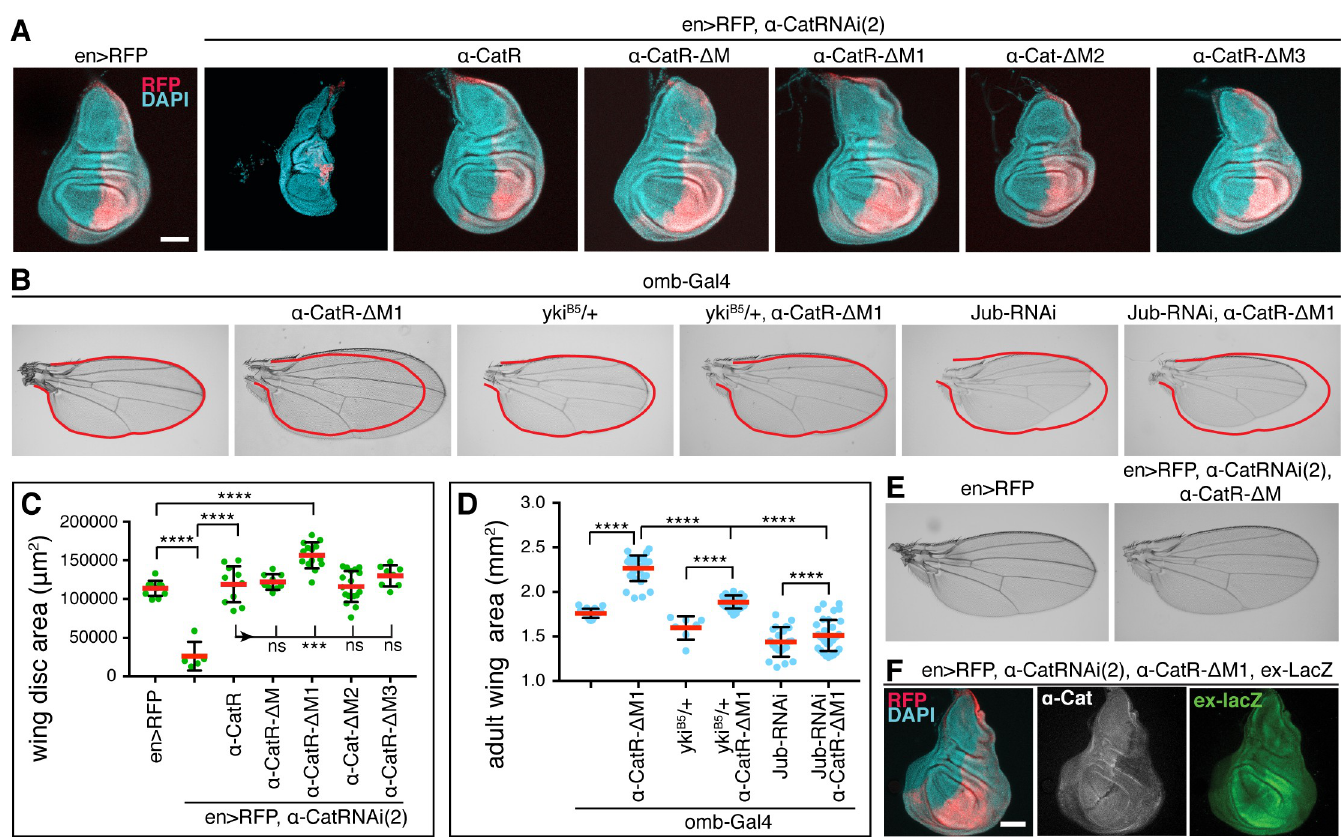
Fig 6. The M1 domain of α -Cat limits Jub- and Yki-dependent tissue overgrowth. (A) Late 3 rd larval instar wing discs of indicated genotypes labeled with DAPI and PC marked by RFP. α -Cat was depleted in PC with α -Cat-RNAi(2) . Scale bars, 100 μ m. (B) Adult wings of flies of indicated genotypes. Both yki B5 /+ and jub-RNAi suppress the overgrowth elicited by expression of α -CatR- Δ M1. (C) Quantification of late 3 rd larval instar wing disc area corresponding to (A) of flies of indicated genotypes. Two-tailed, unpaired t-test was used to determine statistical significance; ���� (P � 0.0001), ��� (P = 0.0003), ns (P > 0.05). (D) Quantification of adult wing area corresponding to (B) of flies of indicated genotypes. Two-tailed, unpaired t-test was used to determine statistical significance; ���� (P � 0.0001). (E) Wing of control ( en > RFP ) and en > RFP , α -Cat-RNAi(2) , α -CatR- Δ M adult fly. (F) Late 3 rd larval instar wing disc of the indicated genotype showing the failure of α -CatR- Δ M1 to rescue tissue overgrowth in an α -Cat compromised background, and ex-lacZ expression remains increased compared to controls (see Fig 2C).